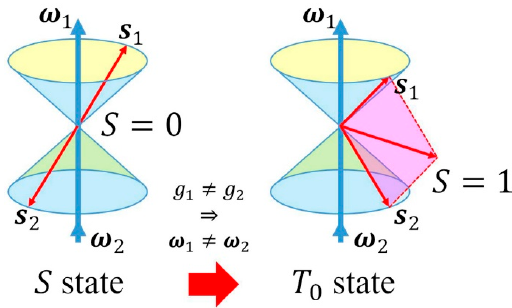
Figure 9. A visualized diagram of the ∆𝑔 mechanism of magnetically induced intersystem crossing.